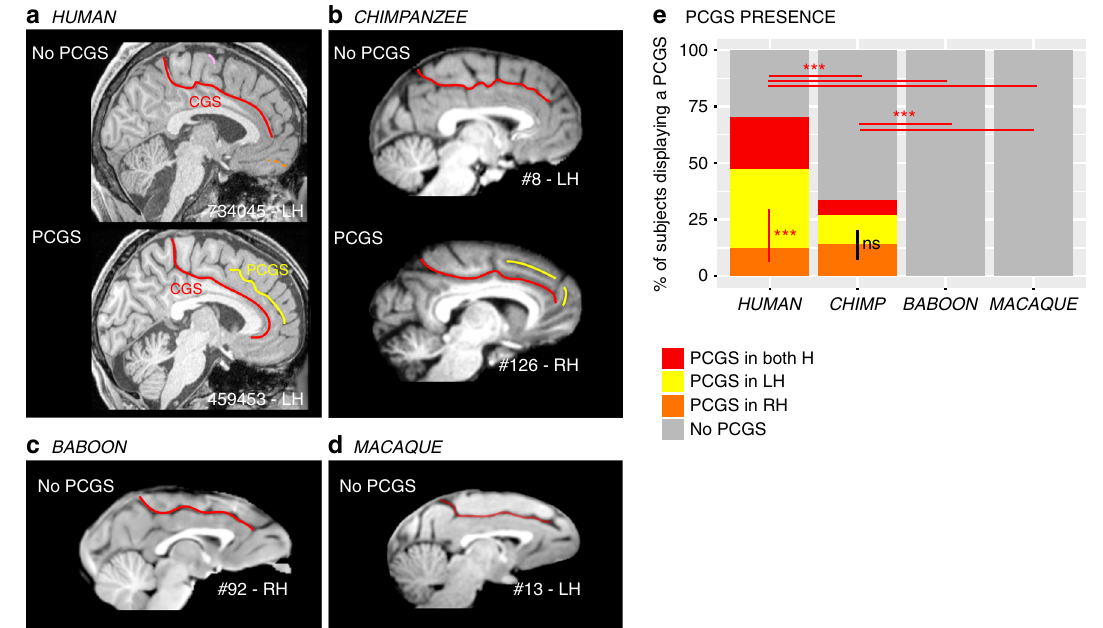
Fig. 1 Presence of the paracingulate sulcus (PCGS) across primates. The location of the cingulate sulcus (CGS) is shown in red in typical hemispheres displaying no PCGS and in those displaying a PCGS in human ( a ) and chimpanzee ( b ), as well as in typical hemispheres of baboon ( c ) and macaque ( d ) brains. The location of the PCGS is shown in yellow in typical hemispheres displaying a PCGS in the human ( a ) and chimpanzee brains ( b ). A PCGS is observed in both human and chimpanzee brains, but not in baboon and macaque brains ( e ). The probability of occurrence of a PCGS decreased from Human to chimpanzee. The PCGS is lateralized in the left hemisphere in human, but not in chimpanzee brains. Statistics: * p < 0.05, ** p < 0.01, *** p < 0.001, ns non-signi fi cant. Source data are provided as a Source Data fi ILS present (0/1), main effect hemispheres (left/right): χ 2 = 3.3591, df = 1, p -value = 0.06684 (ns)), or the macaque brain ( χ 2 = 0.42938, df = 1, p -value = 0.5123 (ns), logistic regression).